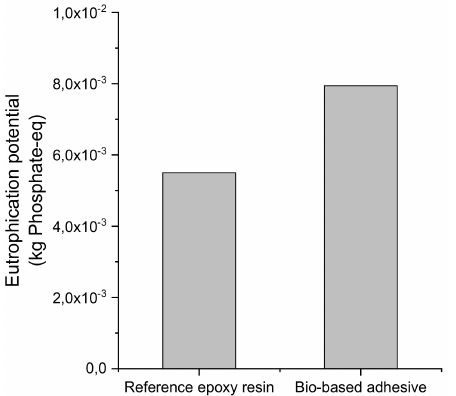
Figure 3. Comparison of EP in terms of equivalent amount of PO 3 .